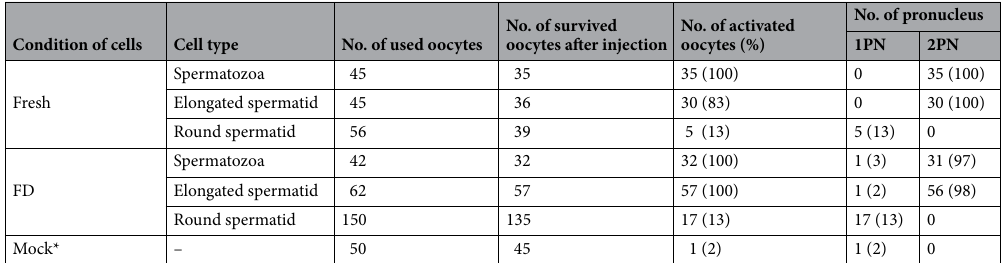
Table 3. Oocyte activation potential of injected male germ cells of different stages with or without freeze- drying treatment. PN: pronucleus. *For manipulation control, medium were injected into oocytes without nucleus.